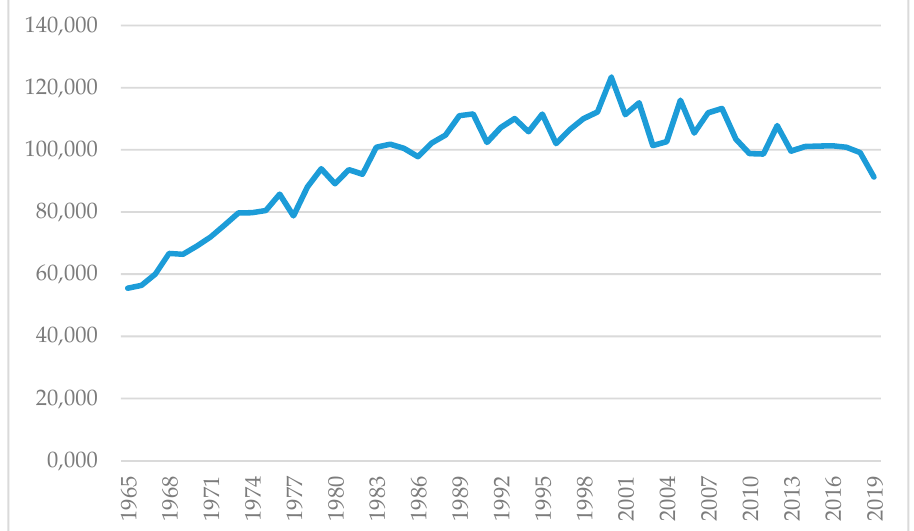
Figure 6. Energy consumption per capita (kWh) in Norway (according to the data source [14]). U.S.A. case. The United States is unable to curb its dependence on imported oil, United States run on fuel made from imported